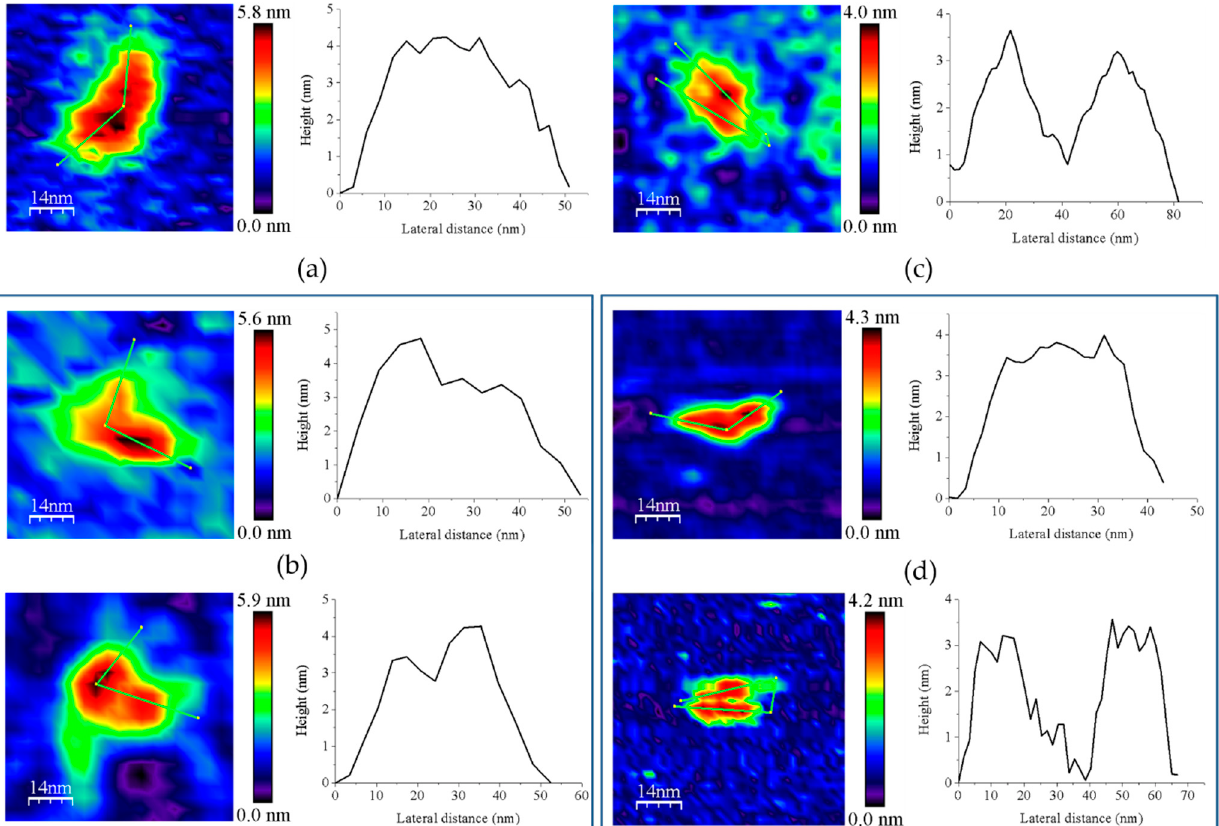
Figure 8. Representative main 2D features and Z-height profiles as visualized by AFM imaging for ( a ) GvFFTRC135S homodimers; ( b ) GvFFTRC135S homodimers covalently bound to GvTrxmC35S, GvFFTR:GvTrxm; ( c ) CaFFTR2C131S homodimers; and ( d ) CaFFTR2C131S homodimers covalently bound to CaTrx2C32S, CaFFTR:CaTrx2. Samples were measured in PBS pH 7.0. Z-height profiles correspond to the green lines traced on the 2D topography images. ( b , d ) Images for the two preferred associations observed. Scan sizes for all AFM images are 70 nm × 70 nm.